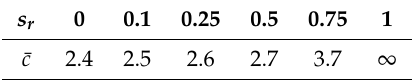
Table 1. The table shows the recommended MP parameters ¯ c if one wants to minimise the main performance objective V M (Equation (42)) for different servo-regulator parameters s r in Equation (41). The optimal ¯ c values as indicated are almost constant in the interval δ ∈ [ 1.1,3.4 ] ([2]). s